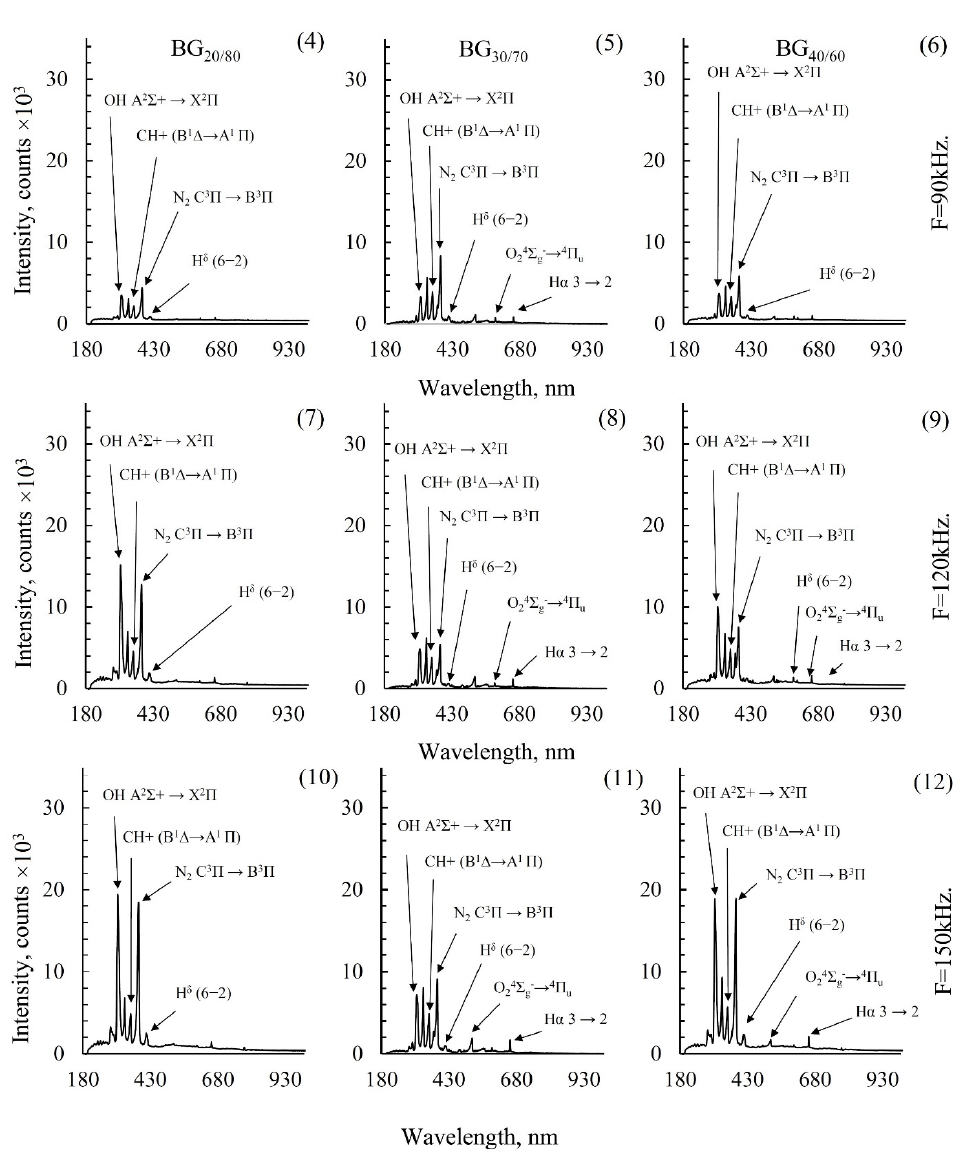
Figure 5. Emission spectrometry of biogas. U = 8300 V, F = 90–150 kHz, (4), (7), (10)—BG 20/80 , (5), (8), (11)—BG 30/70 , (6), (9), (12)—BG 40/60 .